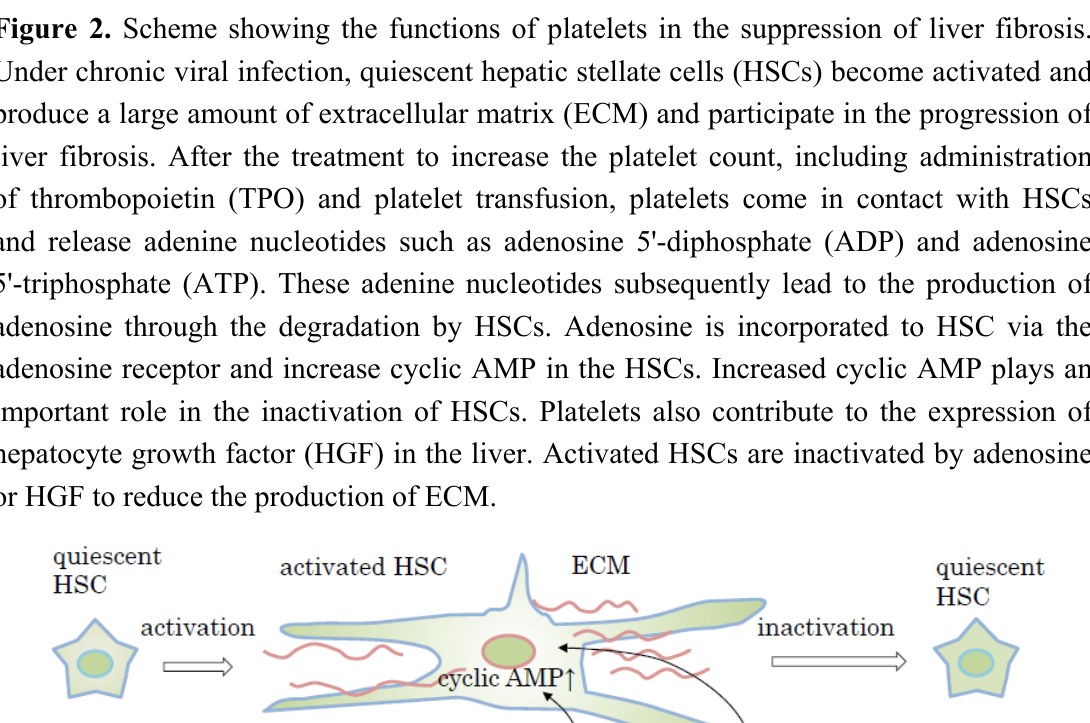
Figure 2. Scheme showing the functions of platelets in the suppression of liver